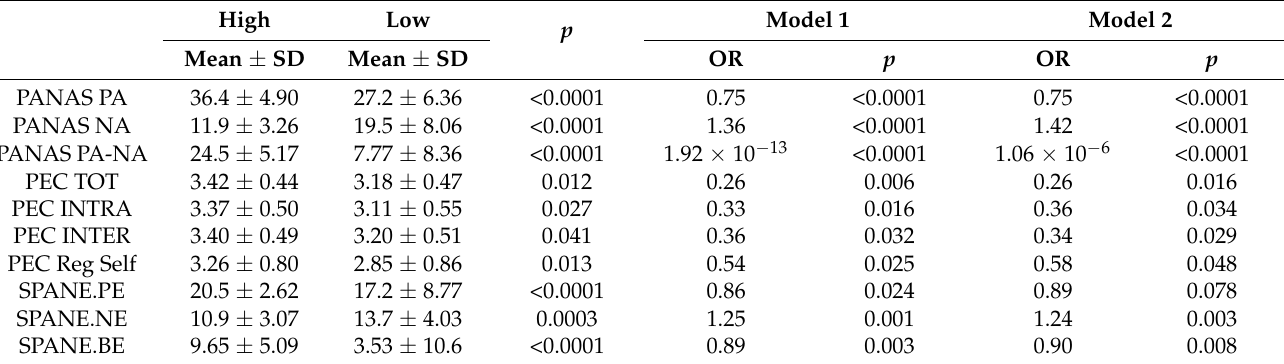
Table 1. Psychological parameters in obese subjects with High and Low mood scores